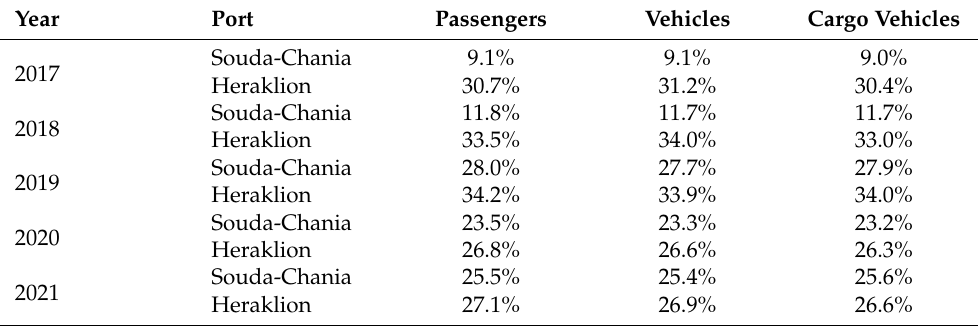
Table 11. Additional fare cost percentage per transportation category (passenger